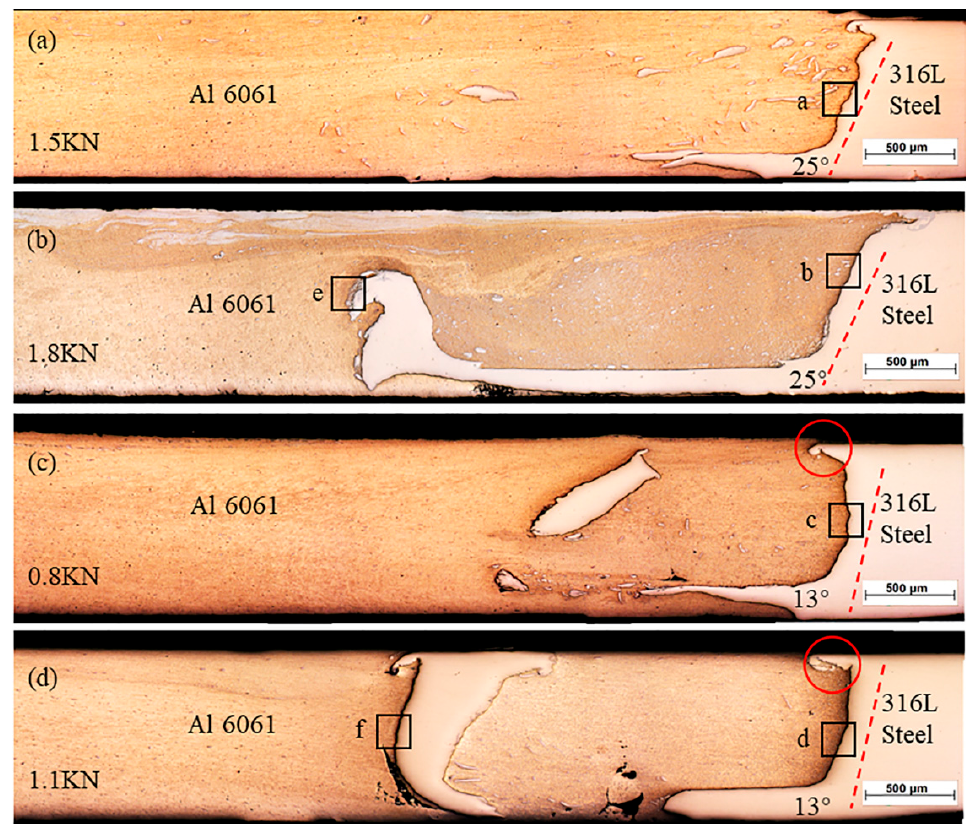
Figure 4. This picture corresponds to the Zeiss picture of the interface of ( a ) serial number 1, ( b ) serial number 2, ( c ) serial number 3, and ( d ) serial number 4 in Table 2. The red dotted line is the inclination angle of the Fe-Al interface.